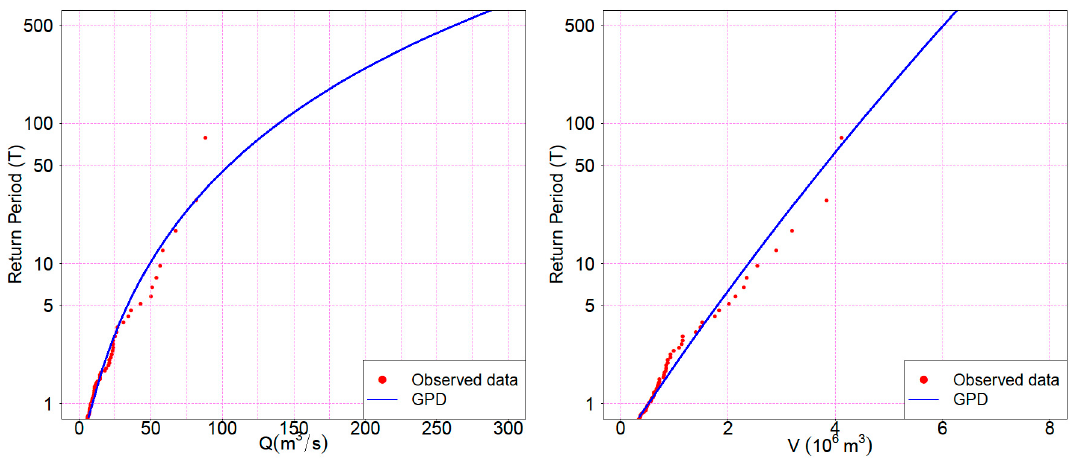
Figure 9. Empirical CDFs and GPD with PWM parameter estimation. Summer season.